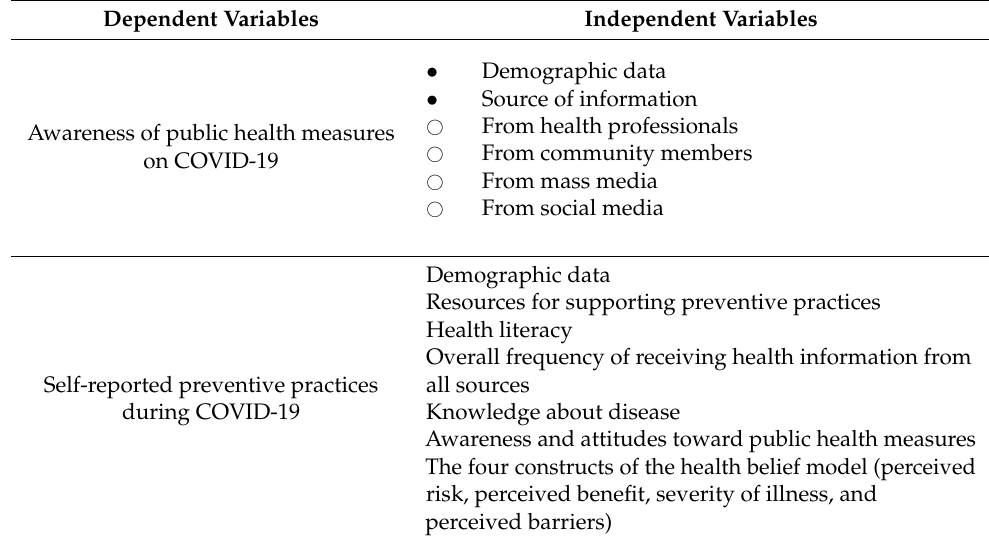
Table 1. Dependent variables and independent variables for analytic study.